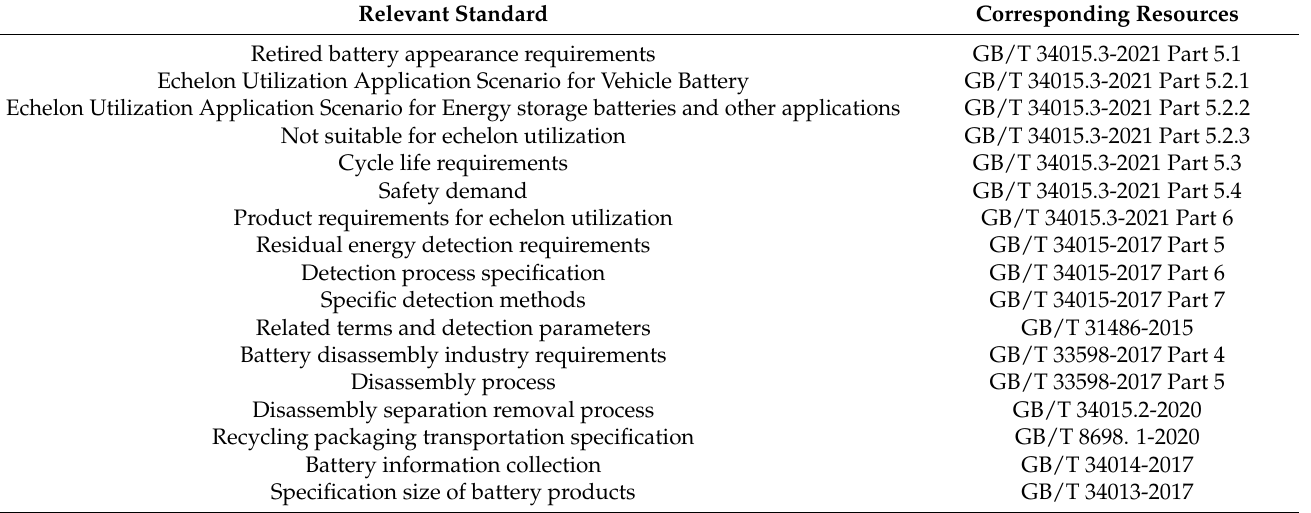
Table 4. Related standards for echelon utilization in EV batteries (in